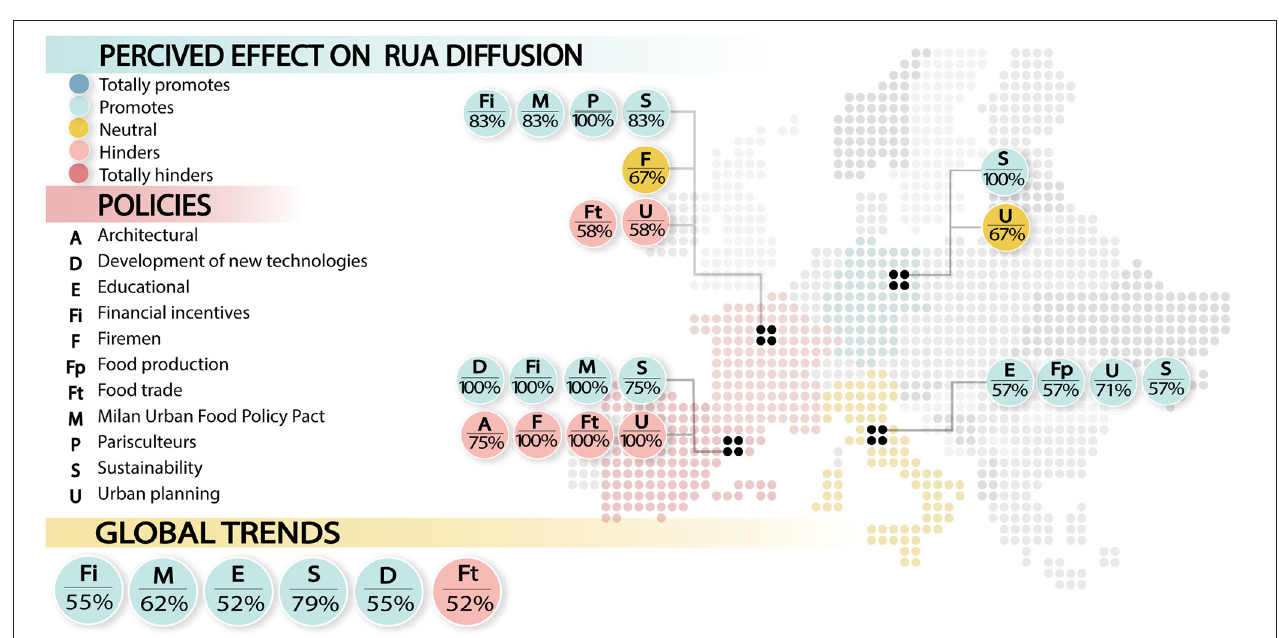
FIGURE 6 | Policies and perceived effect on RUA diffusion in four European cities.